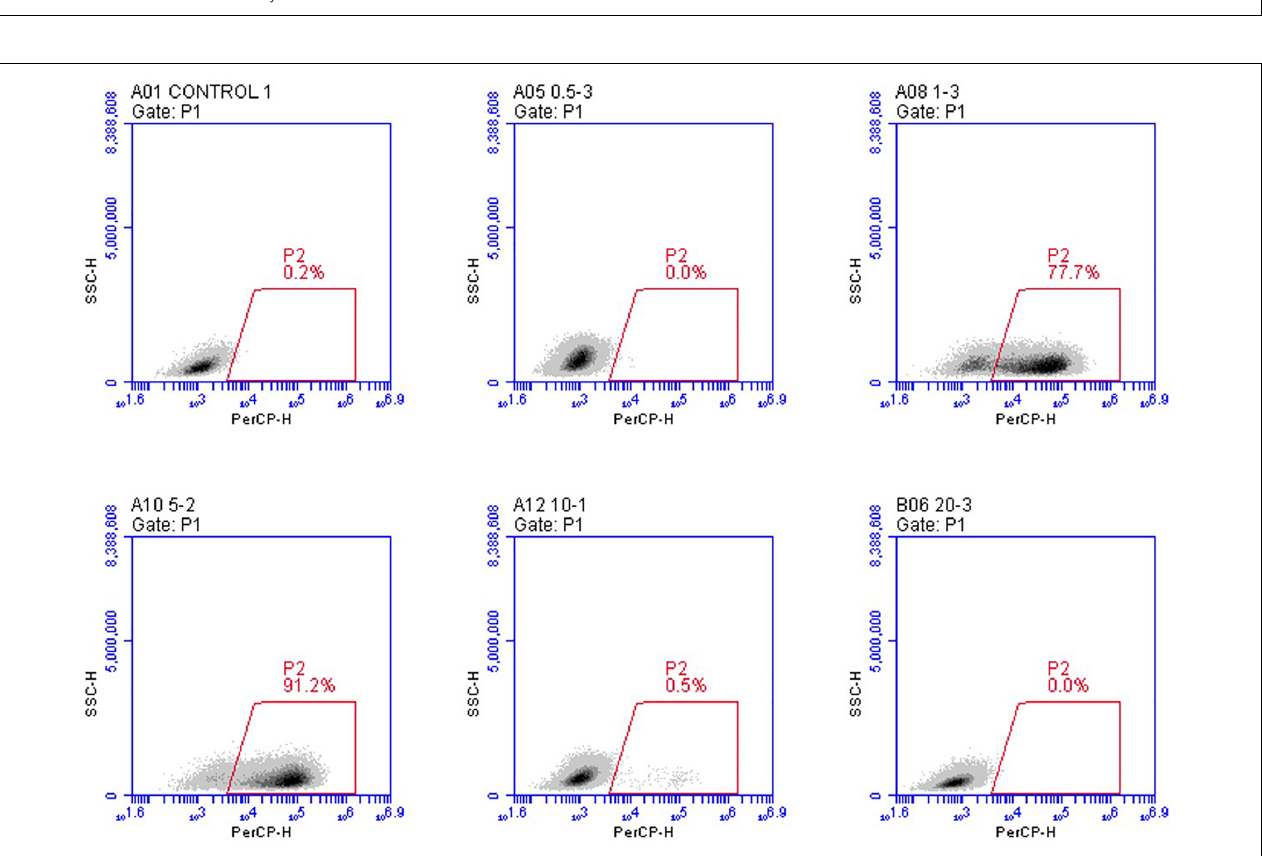
FIGURE 3 | In vitro analysis of the infection efficiency under the mCherry channel using flow cytometry. rVSVmc-p was used to infect BHK-21 cells at the indicated MOIs three times. Infected cells have been examined using flow cytometry. mCherry fluorescence signal was used to determine infection potency.